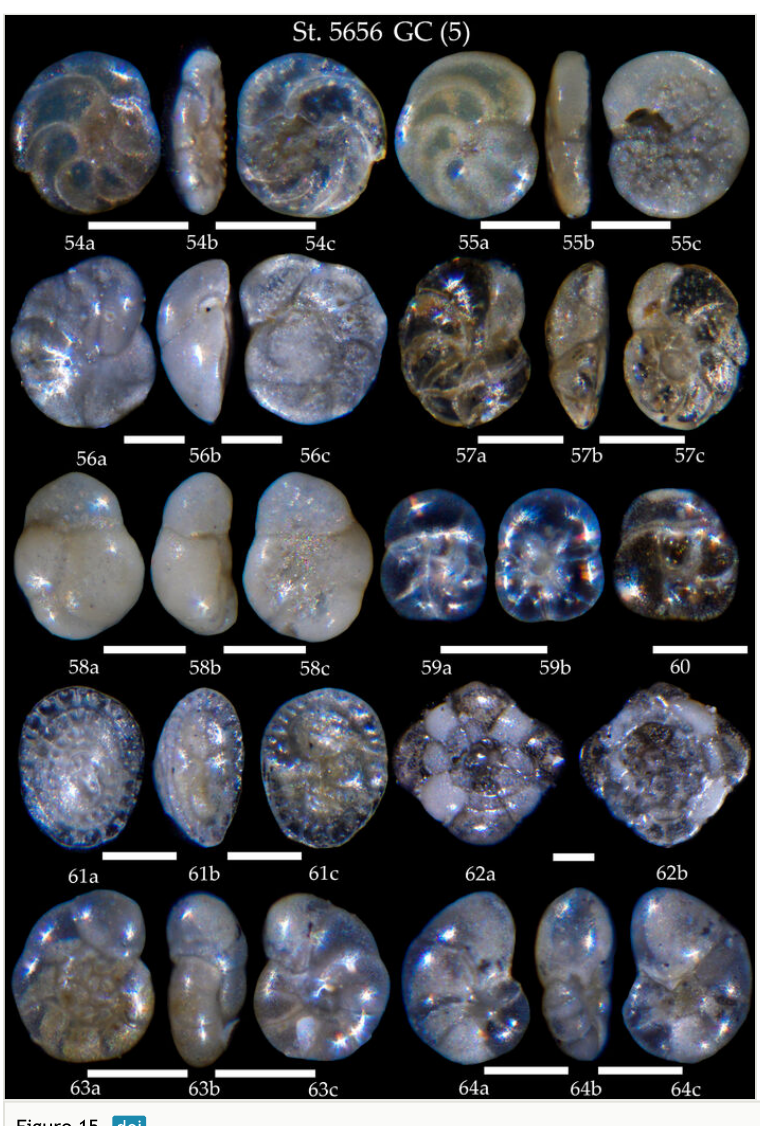
Figure 15. Station 5656 GC (continued). 54 Discorbis sp., a spiral view, b apertural view, c umbilical view; 55 Neoglabratella wiesneri , a spiral view, b apertural view, c umbilical view; 56 Cibicides lobatulus , a spiral view, b apertural view, c umbilical view; 57 Cibicidoides wuellerstorfi , a spiral view, b apertural view, c umbilical view; 58 Sp. cf. C. lobatulus juvenile test, a spiral view, b apertural view, c umbilical view; 59,60 Glabratella altispira , 59a spiral view, 59b umbilical view; 61 Patellina corrugata , a spiral view, b apertural view, c umbilical view; 62 Planorbulina mediterranensis , a spiral view, b umbilical view; 63 Valvulineria rugosa , a spiral view, b apertural view, c umbilical view; 64 Valvulineria minuta , a spiral view, b apertural view, c umbilical view. Scale 100